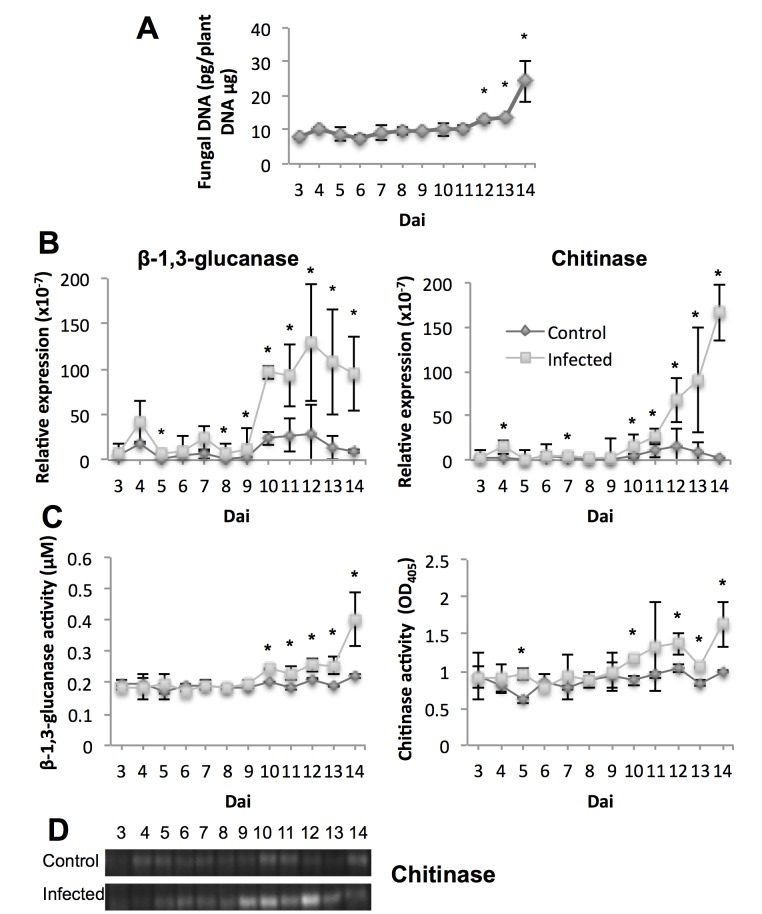
The bioassay to follow disease transition from 3 to 14 dai.(A) Fungal biomass expressed as content of S. tritici DNA. Significant increases (P < 0.05) in levels of fungal DNA are indicated by asterisks. (B) Wheat β-1,3-glucanase and chitinase gene expression analysed by qPCR. (C) β-1,3-glucanase and chitinase protein activities expressed as released glucose (μM) and OD405 measurement based on the assays, respectively. Significant differences (P < 0.05) between infected and control samples are indicated by asterisks. (D) Chitinase protein expression in protein extracts from control (upper panel) and S. tritici-infected leaves (lower panel) analysed by western blotting. Bands indicate chitinase. Representatives of two biological replicates at each time point are shown for the control and infected plants.